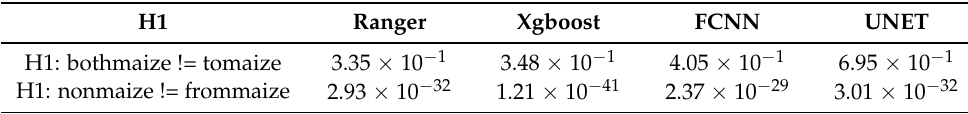
Table 9. Summary of Mann–Whitney U